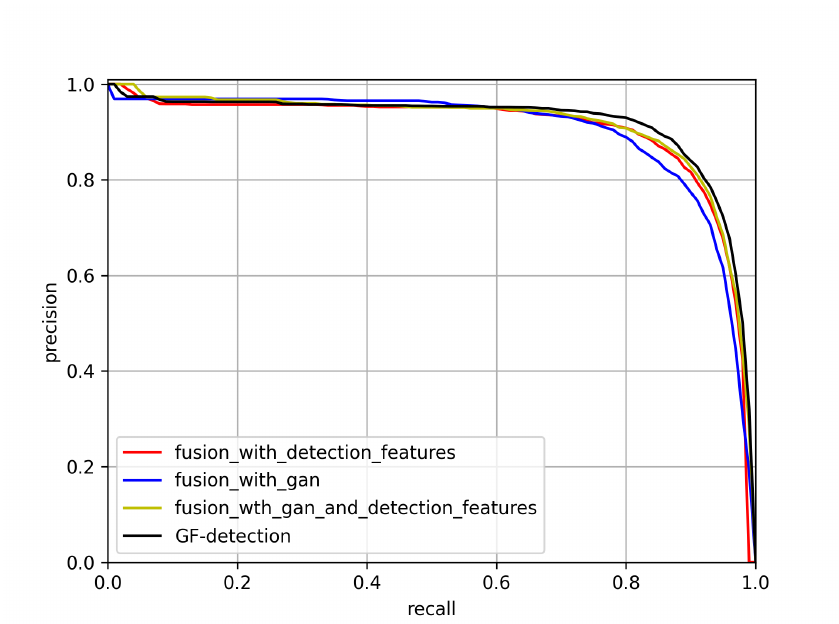
Figure 8. PR-Curve of four fusion models.